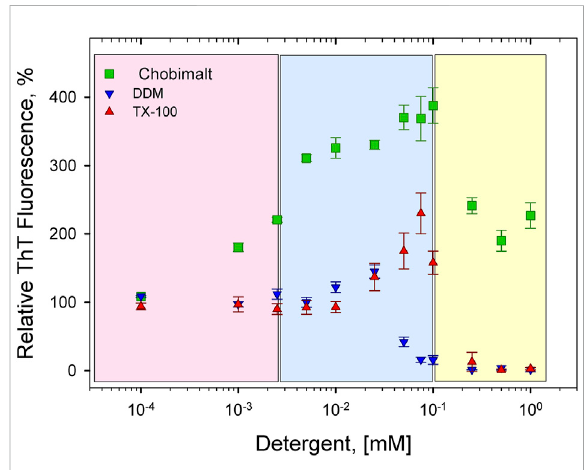
FIGURE 2 Concentration-dependent effect of Chobimalt on insulin fi brillization monitored by ThT fl uorescence assay. The effect of Chobimalt on insulin fi brils formation was quanti fi ed as a function ofChobimaltconcentrationrangingfrom0.1 µMto1 mMata fi xed 25 µM concentration of insulin. Three colored areas represent a different fi brillization behavior as a function of Chobimalt